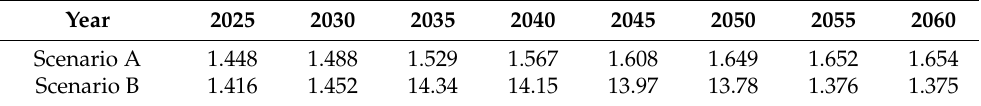
Table 10. Population prediction